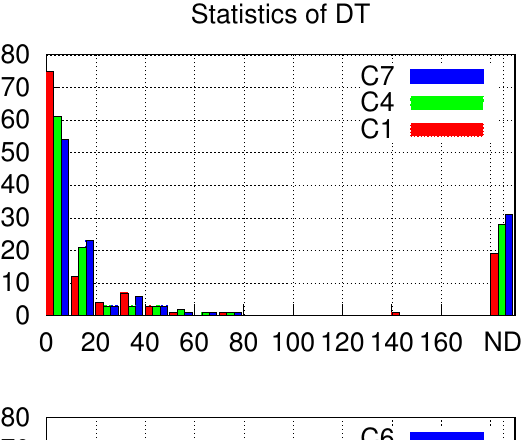
Fig. 11. Pie chart of main changes resulting from the use of the 7 configurations of Table 4. The records are grouped according to the following categories: (TD – light blue) number of records where all configurations make exactly the same detection; (TD: var(DT) – green) number of records where all configurations detect a tsunami, but with changes in DT; (missed – red) number of records where all configurations fail to detect a tsunami; (missed ←→ TD – yellow) number of records where some configurations detect a tsunami and some others do not. The inner of the pie-chart shows the statistics of false detections. Four categories are identified: (NF M = NF m = 0 – white) number of records where all configurations see no false detections; (NF M = NF m > 0 - black) number of records where all the configurations see exactly the same false detections; (NF M 6= NF m > 0 – grey) number of records where all configurations see false alerts but differing in number; (NF M 6= NF m = 0 – light grey) number of records where some configurations see false detections and some others do not.